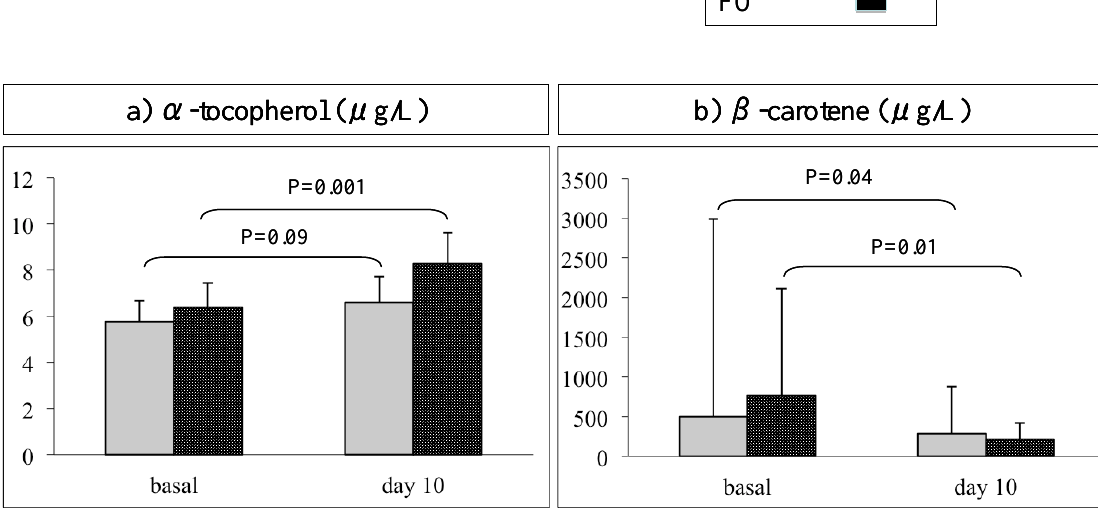
Figure 1. Differences between the levels of α-tocopherol (a) and β-carotene (b) within 10 days of NP compared to baseline in each group, soybean and fish oil-containing